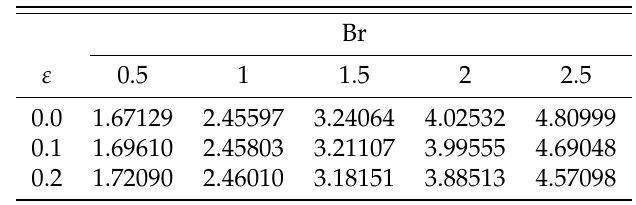
Table 4. Z (Heat transfer coefficient) as a function of Br and ε . Here x = 0.1, Q = − 1.2, β 1 = 0.2, β 2 = 0.2, ϕ = π /4, M = 4, λ 1 = 1.